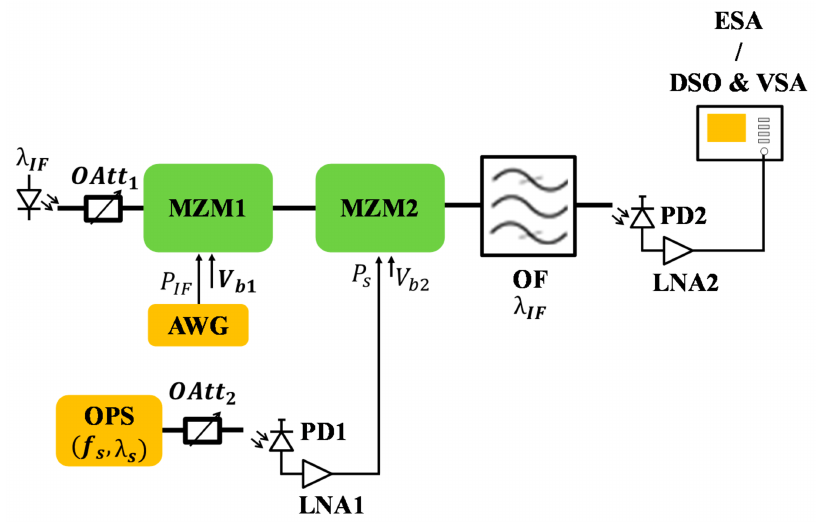
Figure 6. Experimental setup for an electro-optical mixing using a cascaded MZMs link. VSA: vector signal analyzer, DSO: digital sampling oscilloscope, OPS: optical pulse source, and AWG: arbitrary waveform generator.